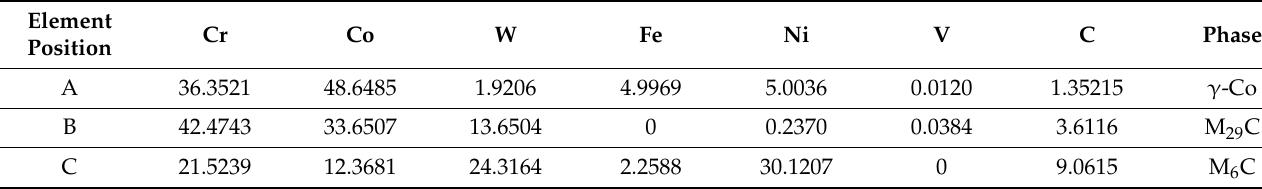
Table 2. The EPMA result (In the result, C is a light element and cannot be precisely measured by the EPMA. Therefore, the result is semi-quantitative for the C element.) of phases in the pure Co–Cr–W alloy (at. %).